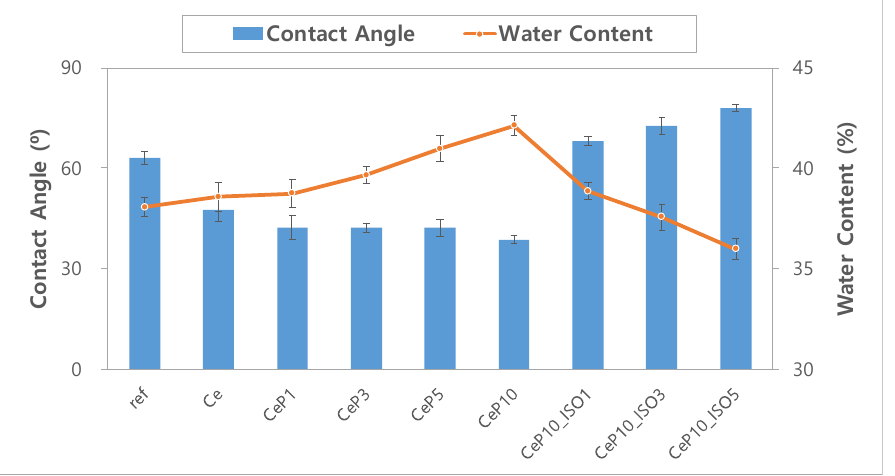
Figure 7. Change in contact angle and water content of samples.